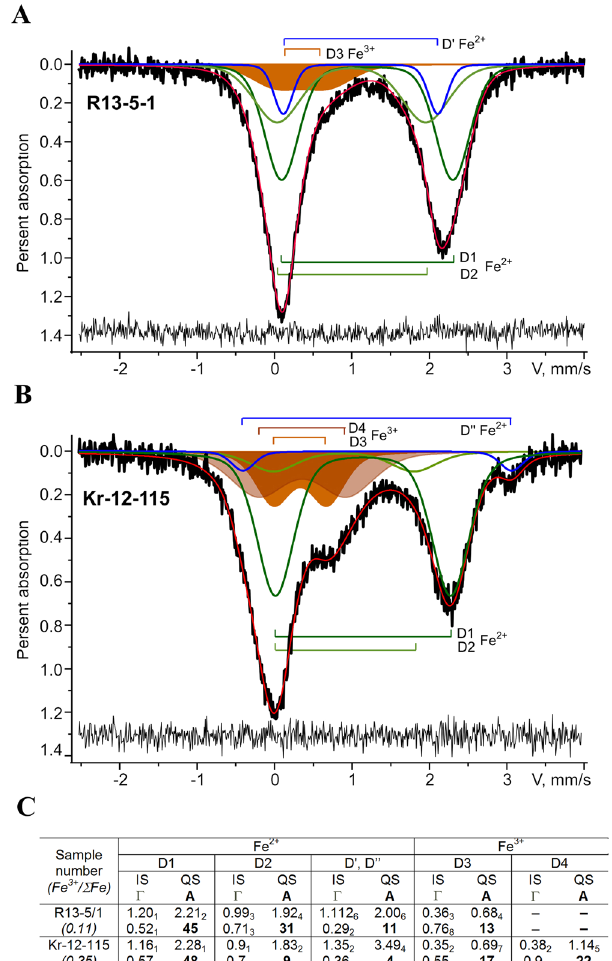
Figure 7. Mössbauer spectra of the impact glasses of the Ries ( A ) and Kara (B ) craters. Indicated components are the results of the best fits. Residual spectra are shown below. Mössbauer parameters of the best fits components, where IS (mm/s), QS (mm/s), Г (mm/s), A (%) – isomer shift, quadrupole splitting, half-width of doublet peaks, relative area of the doublet. Fe 3 + / Σ Fe = Σ A Fe 3 + /( Σ A Fe 2 + . + k∙ Σ A Fe 3 + ), where k is the ratio of probabilities of Mössbauer transition of octahedral complexes Fe 3 + and Fe 2 + , k is taken equal to 1.2 32,33